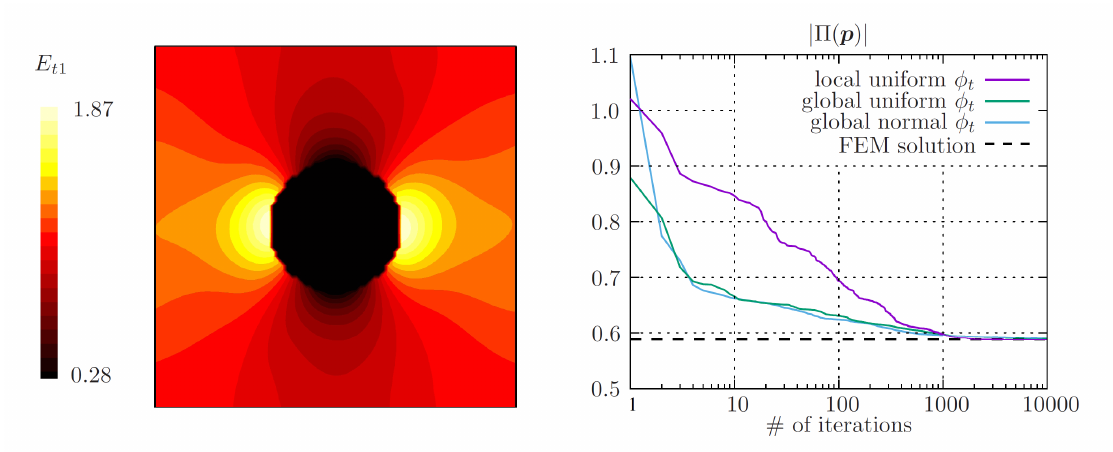
Figure 9. ( left ) Contour plot of E t 1 for the piecewise-defined trial function in Equation (38) after 10,000 iterations in the optimization procedure; and ( right ) optimization of Π ( p ) vs. iteration count for the piecewise-defined trial function with uniformly distributed weight initialization and the global trial function (33) with uniformly and normally distributed weight